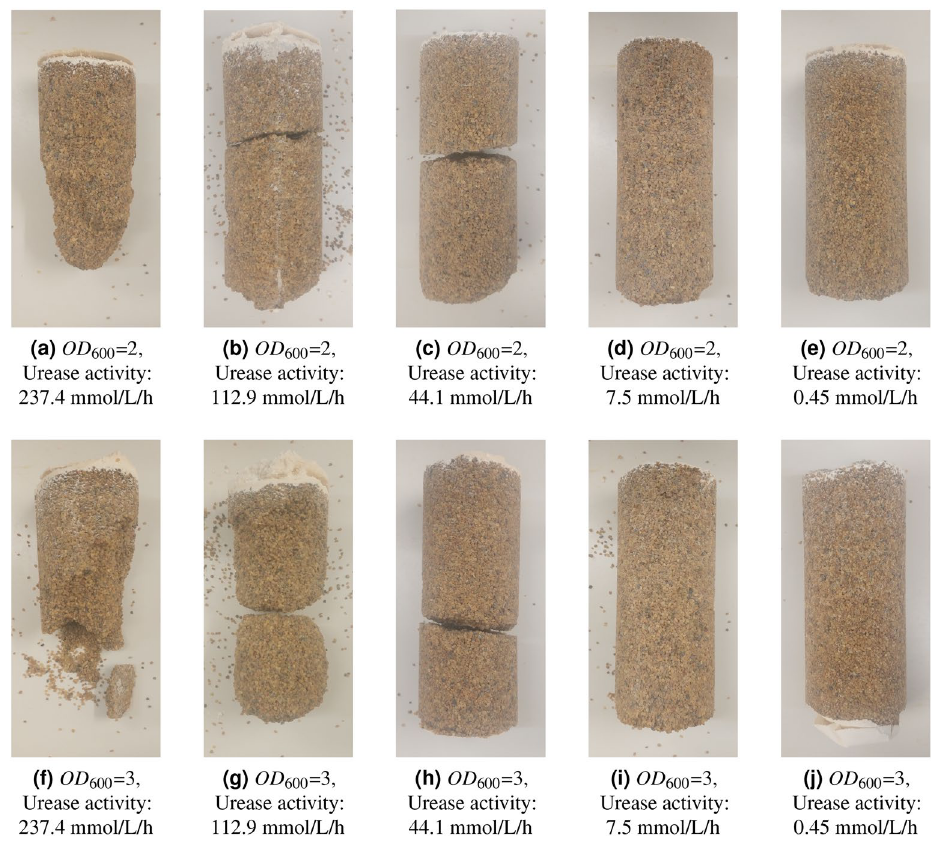
Figure 3. ( a – e ) Photographs of specimens taken with OD 600 = 2 and activity in descending order (237.4, 112.9, 44.1, 7.5 and, 0.45 mmol/L/h respectively, measured following the standard protocol 1 ) ( f – j ) Photographs of specimens taken with OD 600 = 3 and activity in descending order as before. The injection was from top to